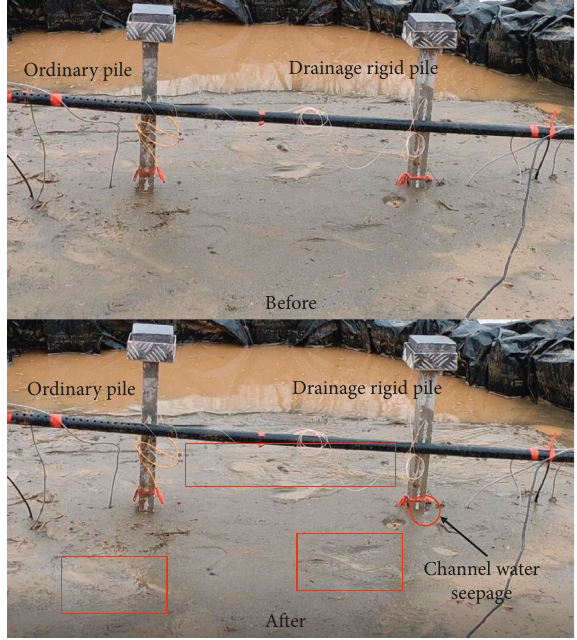
Figure 7: Comparison of before and after the simultaneous fracturing blast vibration